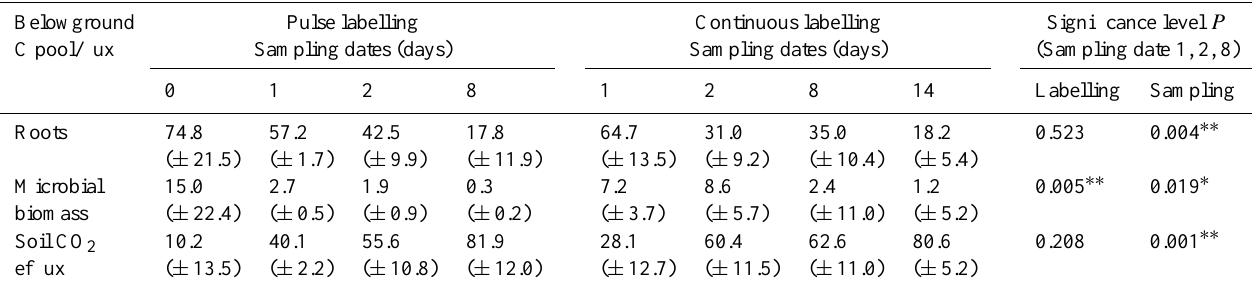
Table 4. Estimation of belowground C partitioning indicated by the relative 13 C distribution (in %) between belowground pools and fluxes measured at different sampling dates after pulse and during continuous labelling ( ± one standard deviation is indicated in brackets). The effects of labelling technique (“labelling”) and sampling date (“sampling”) were tested for the sampling dates in common (1, 2 and 8days) by two-way analysis of variance